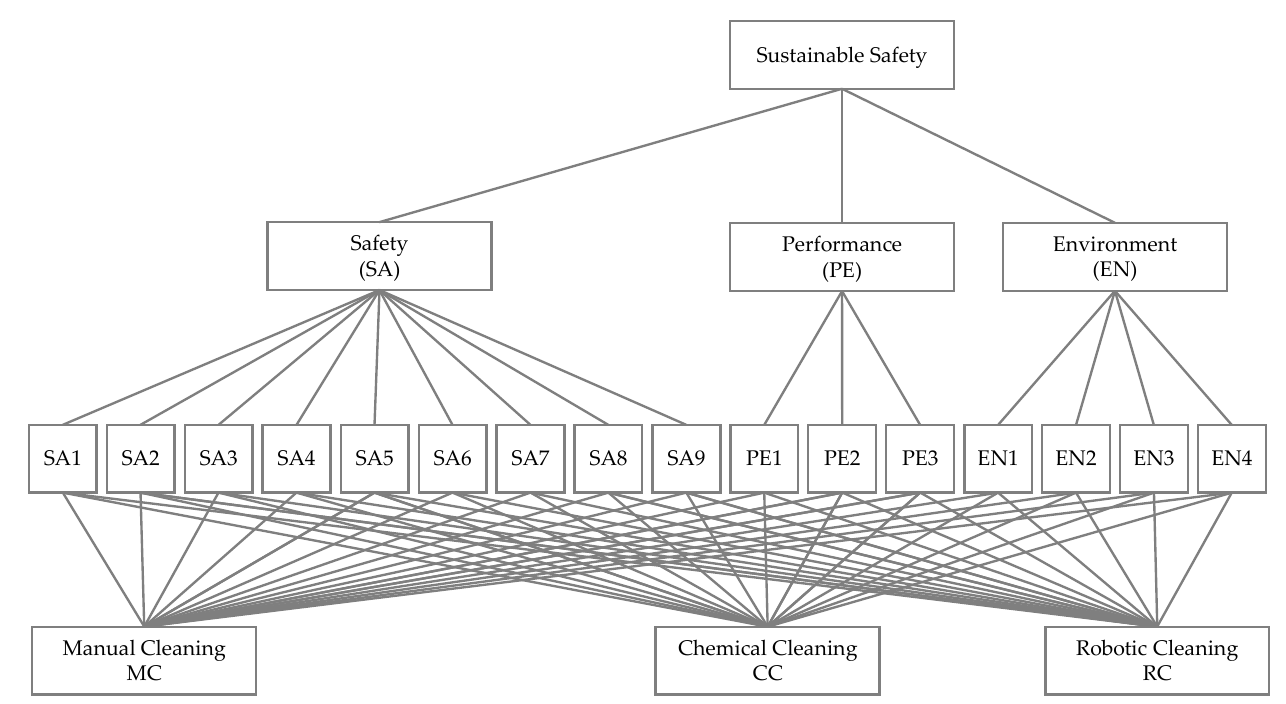
Figure 8. Structure of the problem to be solved by AHP.